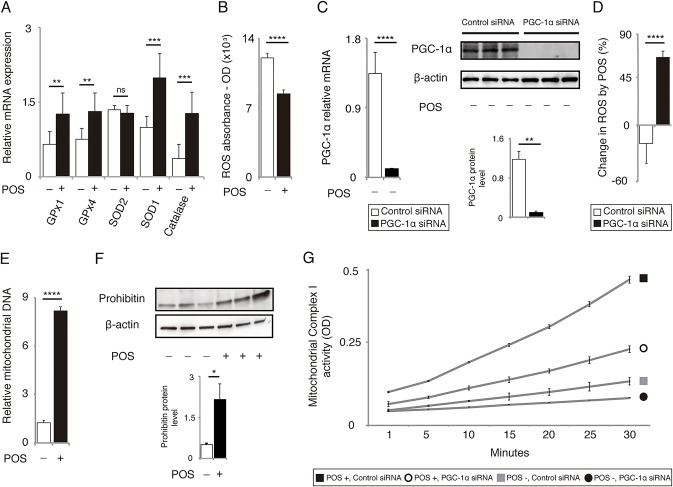
POS treatment decreases ROS level and upregulates mitochondrial biogenesis in ARPE-19 cells through PGC-1α.
(A) POS treatment upregulated mRNA levels of anti-oxidant enzymes including GPx1, GPx4, SOD1 and catalase. Mean ± SEM, n = 6 per group, two-tailed Student’s t-test, ** P < 0.01, *** P < 0.001; ns, not significant. (B) POS treatment downregulated the Intracellular ROS levels evaluated by H2DCFDA. Mean ± SEM, n = 6 per group, two-tailed Student’s t-test, **P < 0.01, ***P < 0.001; ns, not significant. (C) Knockdown Efficacy of PGC-1α siRNA was confirmed by mRNA levels measured by RT-PCR (Mean ± SEM, n = 6 per group, two-tailed Student’s t-test, ****P < 0.0001) and protein levels by western blot analysis (mean ± SEM, n = 3 per group, two-tailed Student’s t-test, **P < 0.01). (D) POS treatment decreased ROS level in cells transfected with control siRNA, but rather increased in those transfected with PGC-1α siRNA. Mean ± SEM, n = 6 per group, two-tailed Student’s t-test, ****P < 0.0001. (E) POS treatment upregulated relative mitochondrial DNA content. Mean ± SEM, n = 6 per group, two-tailed Student’s t-test, ****P < 0.0001. (F) Western blot analysis showed the increased protein level of mitochondrial marker prohibitin in cells treated with POS. Mean ± SEM, n = 3 per group, two-tailed Student’s t-test, *P < 0.05. (G) POS treatment upregulated mitochondrial complex I activity in cells transfected with control siRNA, (n = 8 per group, Tukey’s test, P < 0.001), but not in those transfected with PGC-1α siRNA (n = 8 per group, Tukey’s test, P > 0.05).